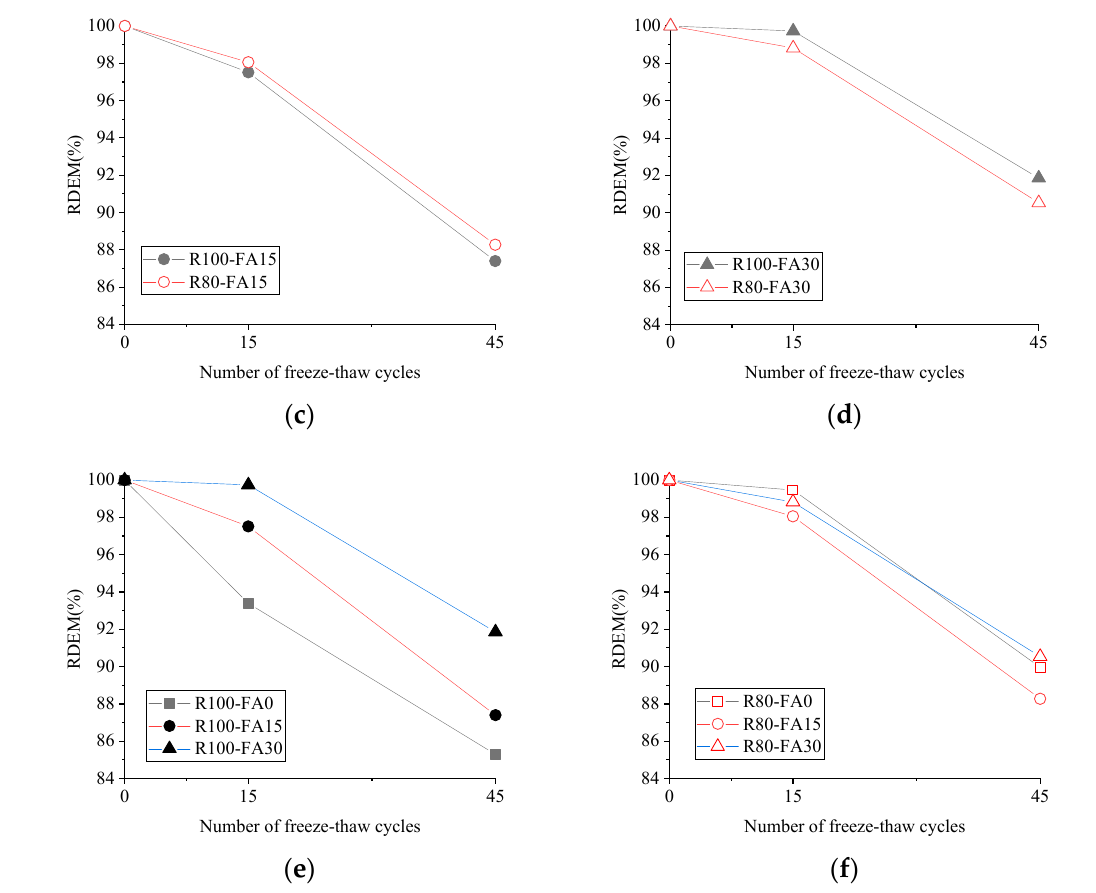
Figure 8. The RDEM of concrete exposed to 3%NS-45FT. ( a ) All, ( b ) FA0, ( c ) FA15, ( d ) FA30, ( e ) R100, ( f ) R80. Note: R is for recycled brick-concrete aggregate; FA is for fly ash; numbers are the value of replacement rate (%).